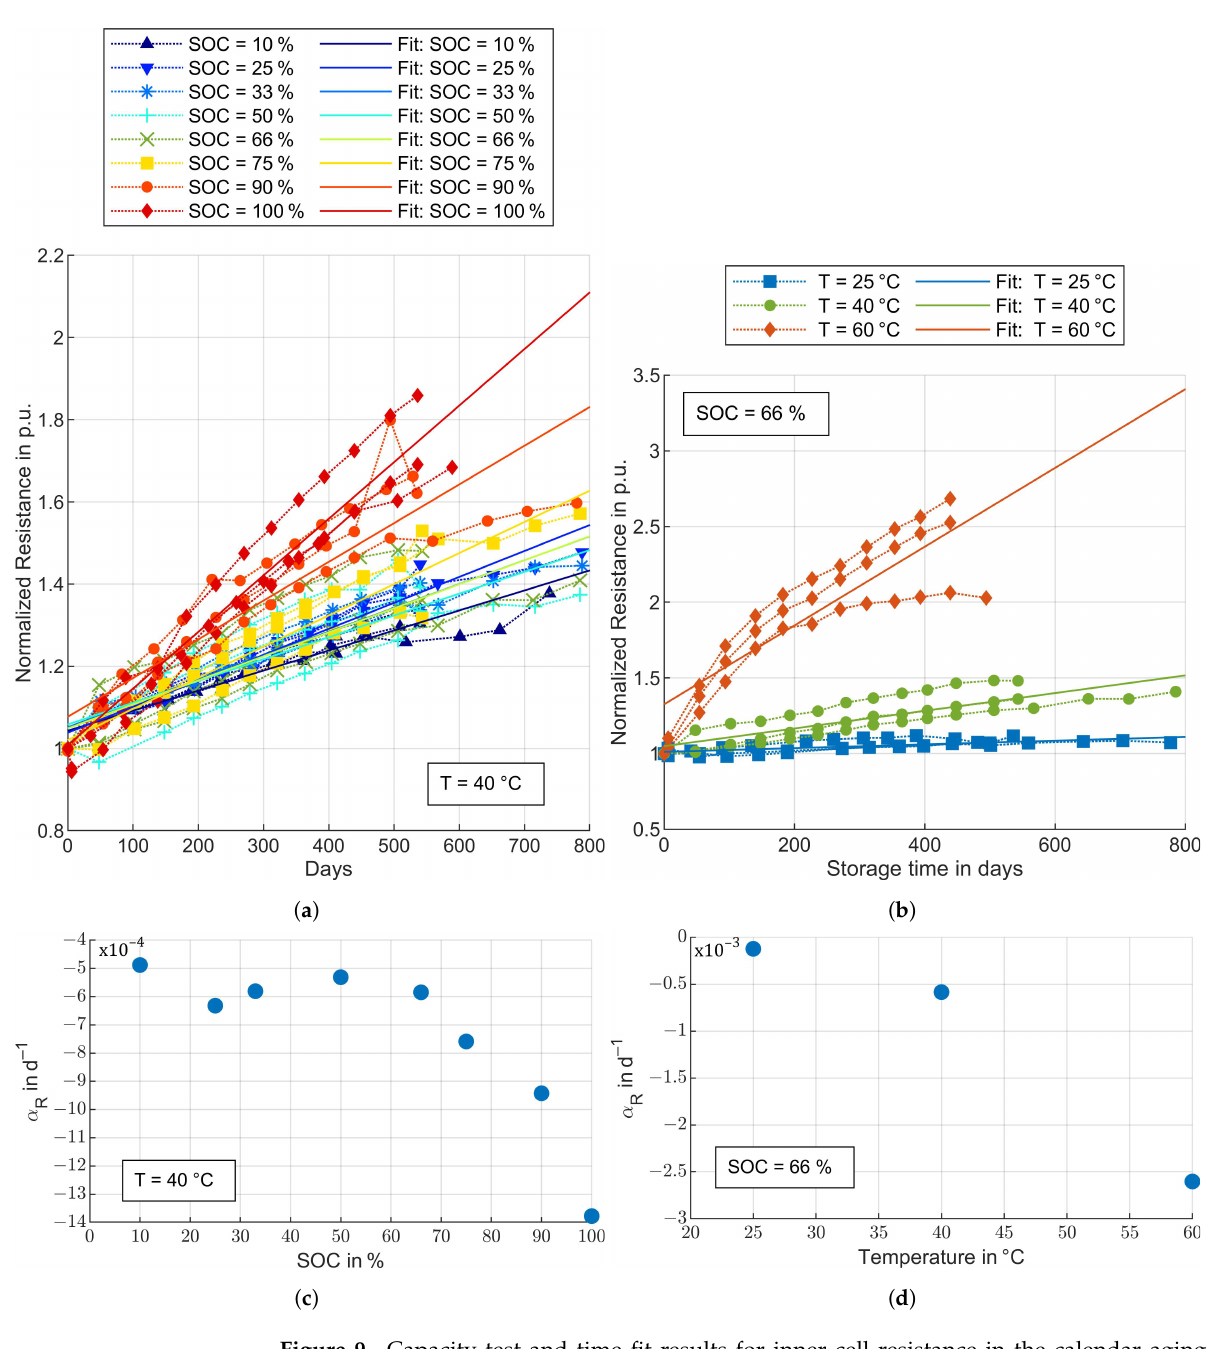
Figure 9. Capacity test and time fit results for inner cell resistance in the calendar aging tests. ( a ) Inner resistance measurement and time fit results for cells stored at 40°C in the calendar aging tests; ( b ) Inner resistance measurement and time fit results for cells stored at 66% SOC in the calendar aging tests; ( c ) Linear coefficient α R of the time fit results for cells stored at 40°C in the calendar aging tests; ( d ) Linear coefficient α R of the time fit results for cells stored at 66% SOC in the calendar aging